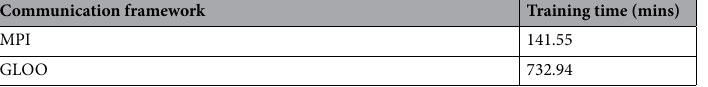
Table 3. AlexNet using GLOO framework or MPI framework to classify the